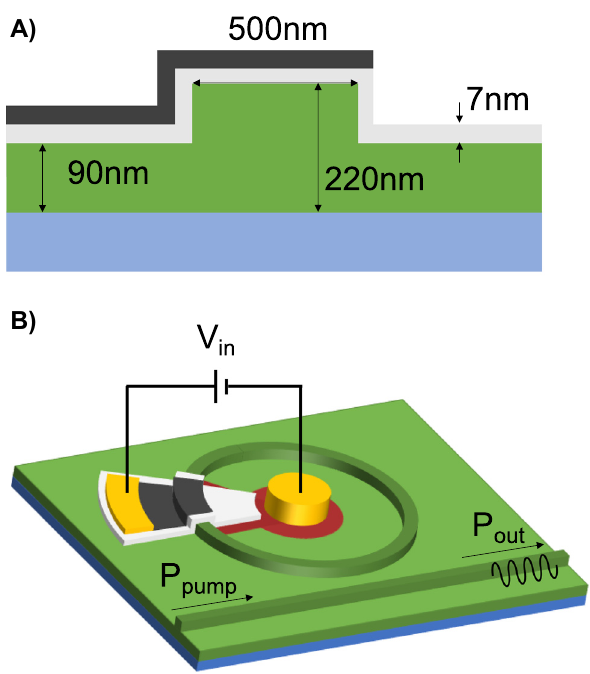
Figure 1: The physical structure of the proposed device. Note the diagram is not to scale for clarity.